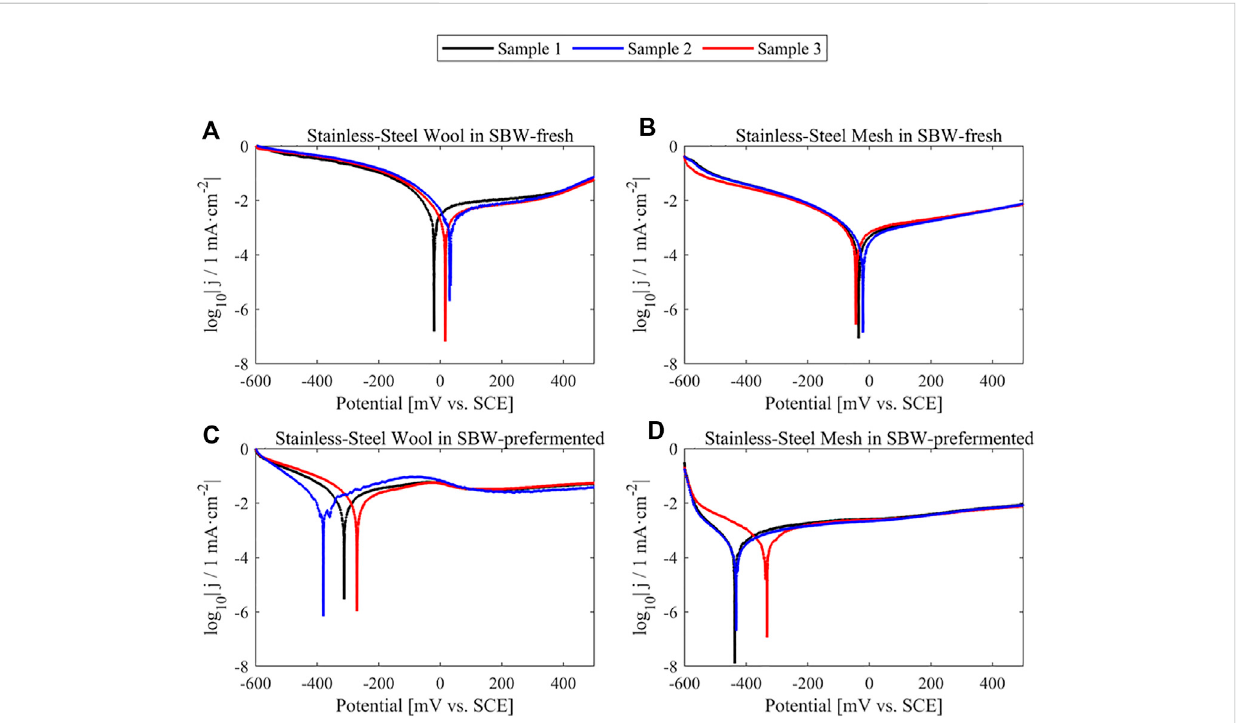
Triplicate linear-sweep voltammetries of clean metallic anode materials in abiotic conditions, shown in logarithmic representation for graphical Tafel parameter determination. (A) Stainless-steel wool in medium SBW-fresh (B) Stainless-steel mesh in medium SBW-fresh (C) Stainless-steel wool in medium SBW-prefermented (D) Stainless-steel mesh in medium SBW-preferemented.